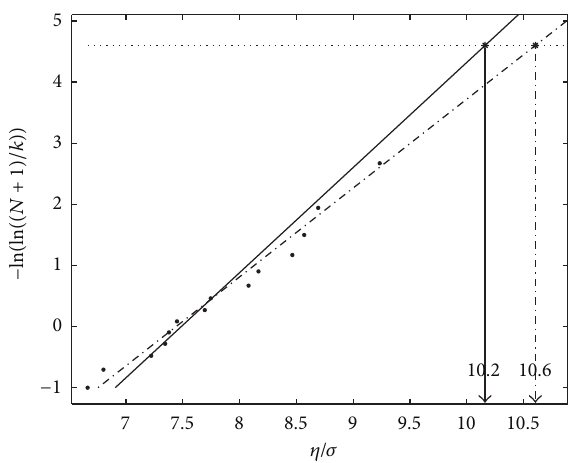
Figure 13: Part of the narrow-band response time series of the linear oscillator with fully sampled and peak values